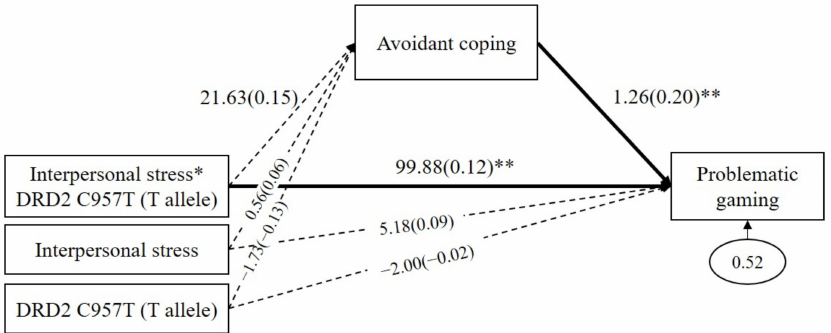
Figure 2. Mediated moderation model with avoidant coping as the mediator in the interaction effect of the DRD2 C957T and interpersonal stress on problematic gaming. Sex, impulsivity, depression, anxiety, and ADHD were controlled for in all analyses (paths not shown for simplicity). Unstan- dardized (outside parentheses) and standardized (inside parentheses) coefficients are shown. Solid lines represent statistically significant coefficients. Dashed lines represent statistically insignificant coefficients; * p < 0.05, ** p <